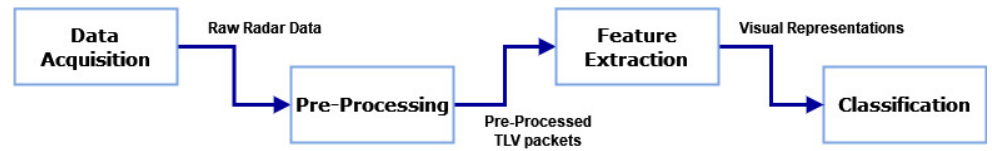
Figure 1. Acquisition and classification pipeline. From left to right, the respective processing steps are data acquisition, preprocessing, feature extraction, and